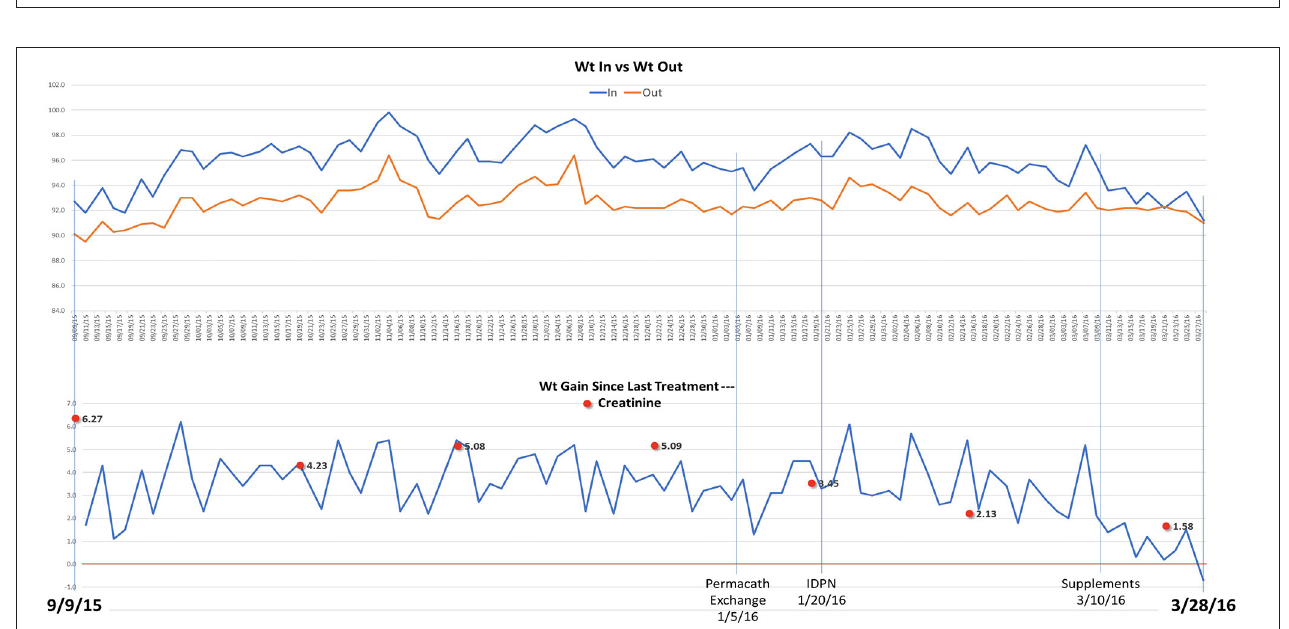
FIGURE 2 | Disease course and treatment.